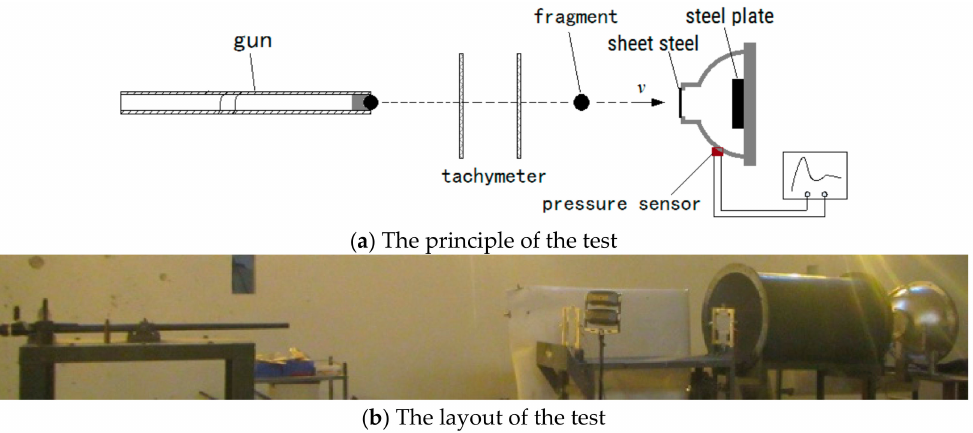
Figure 5. The principle and layout of the test site for fragment impact-induced